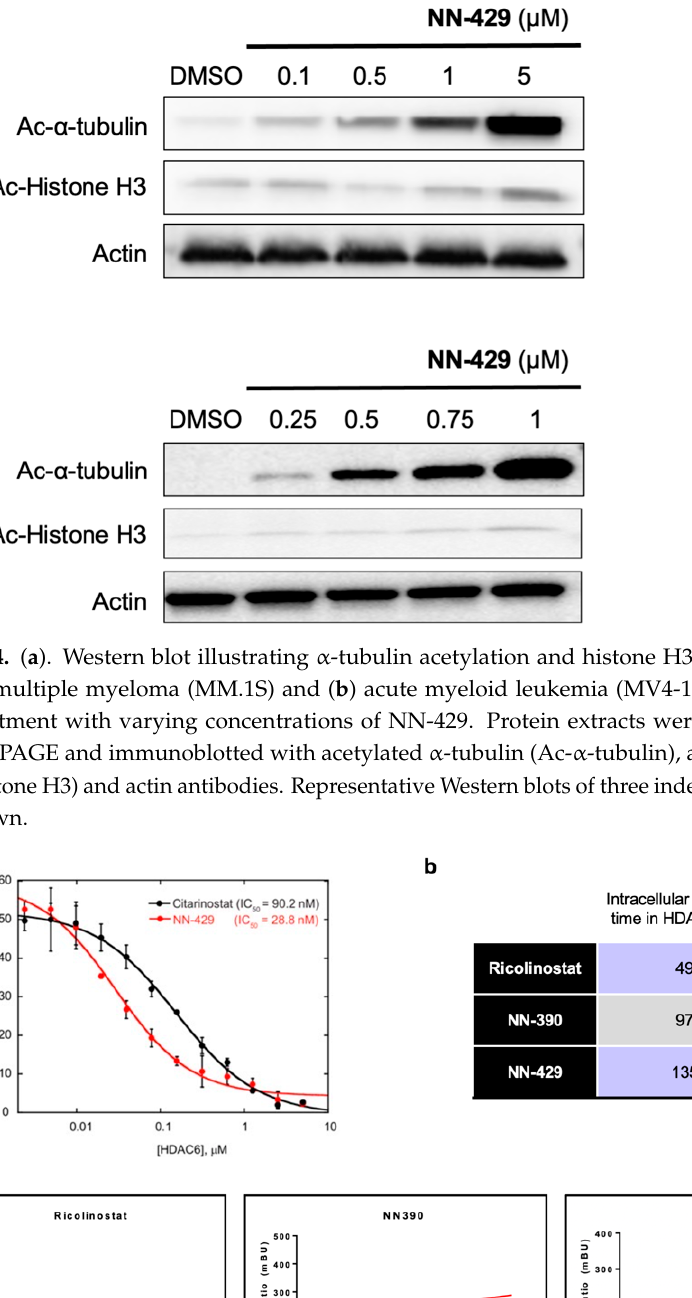
Figure 5. ( a ). Dose–response curves of NN-429 and citarinostat against recombinant zf HDAC6 using fluorescence polarization. Fluorescence polarization IC 50 data against zf HDAC6 is provided. ( b ). In cellulo residence time of selected compounds for HDAC6 target engagement in HeLa cells transi- ently expressing HDAC6-NanoLuc full-length fusion protein. ( c ). Residence time analysis of rico- linostat, NN-390 and NN-429 in HDAC6 within live cells.